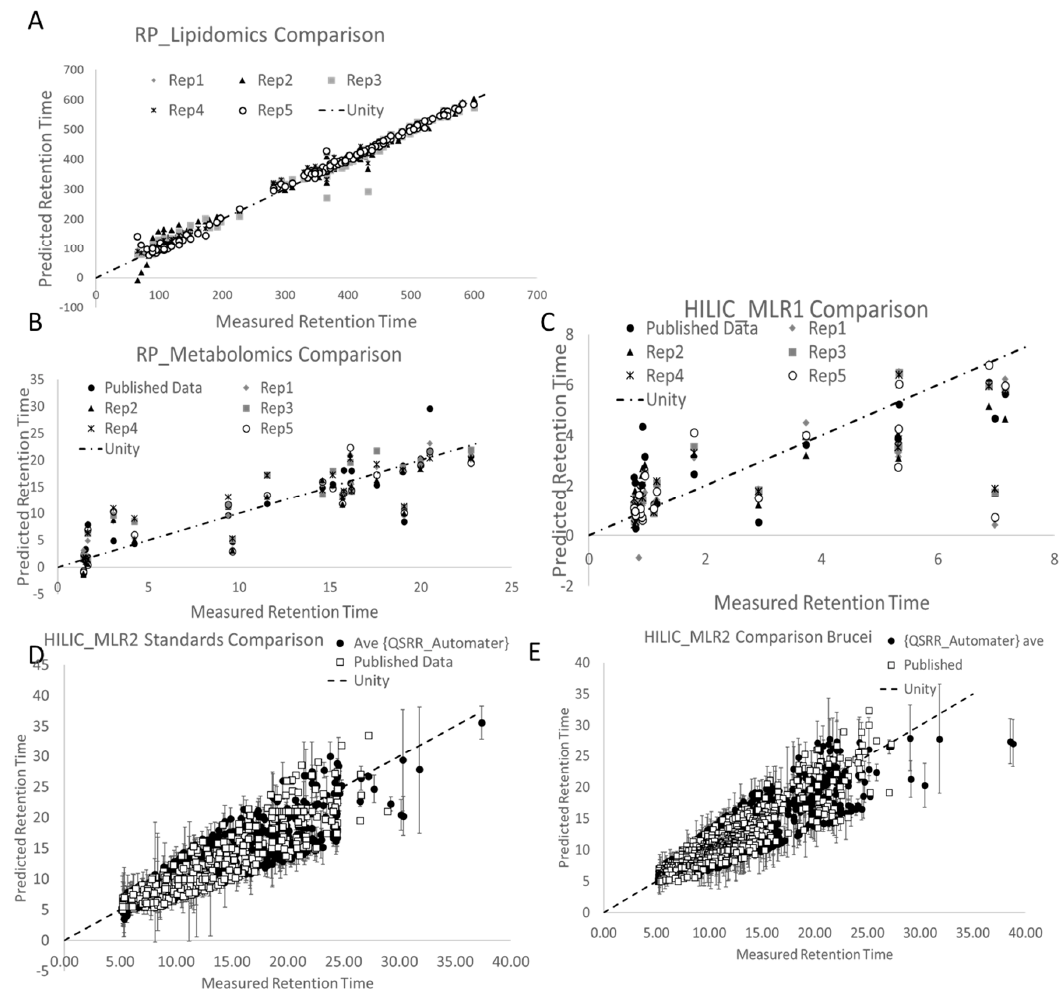
Figure 2. Comparison of QSRR Automator’s Predictions vs. Published. Predictions on published test sets. Unity lines show perfect predictions; Published Data are represented as are individual replicates (rep1-rep5). HILIC_MLR2 is represented with the arithmetic mean to aid readability. A perfect predictive model would put all points on the central unity line. This uses the RP_Lipidomics ( A ), RP_Metabolomics ( B ) HILIC_MLR1 ( C ), and HILIC_MLR2 datasets. HILIC_MLR2 used a mix of